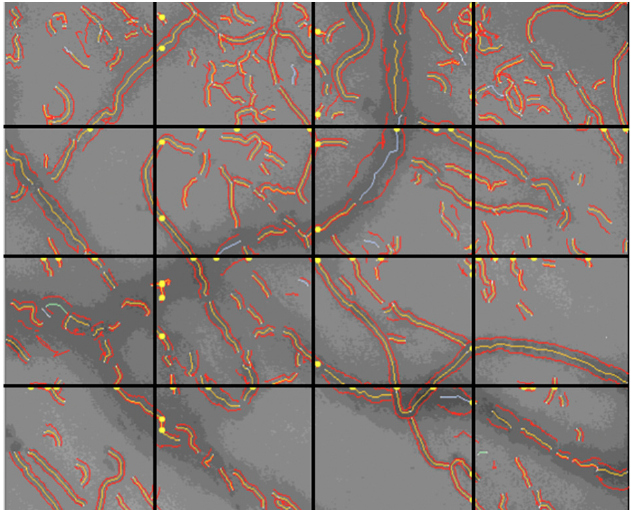
Figure 4. Determination of De Backer Score with vessel segmentation extracted with the AVA soft- ware.